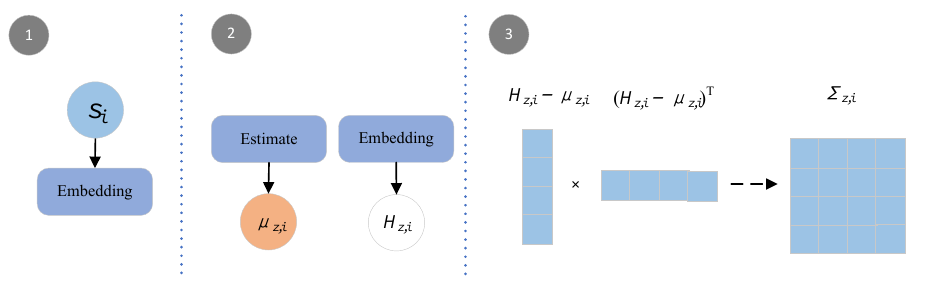
Figure 2. The phase of adaptive estimation. (1) Find the embedding of s i ; (2) Estimate µ z , i and H i ; (3) Get Σ z , i .